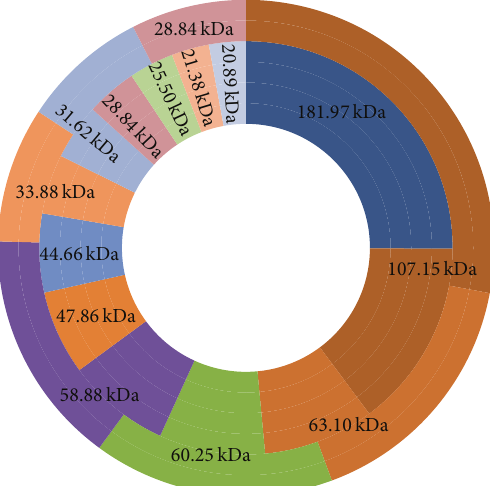
Figure 4: Immunoblot analysis depicted centripetally from M. agalactiae (RPNS 216) WCA; M. agalactiae (RPNS 216) SSA; M. agalactiae (RPNS210)WCA; M.agalactiae (RPNS210)SSA;